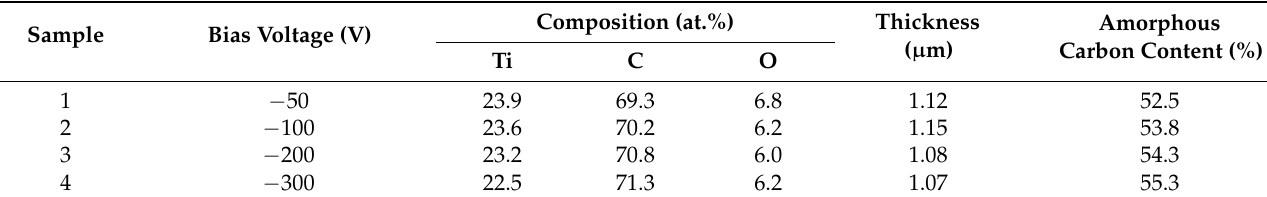
Table 1. The chemical composition, thickness, and deposition parameters of Ti-DLC coating.